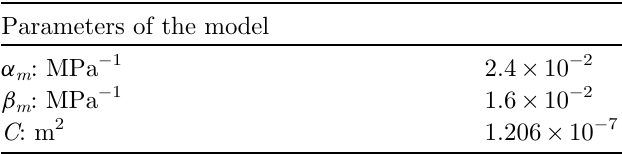
Table 2. Parameters of the model for the 7-mm pellet [7]. Parameters of the model